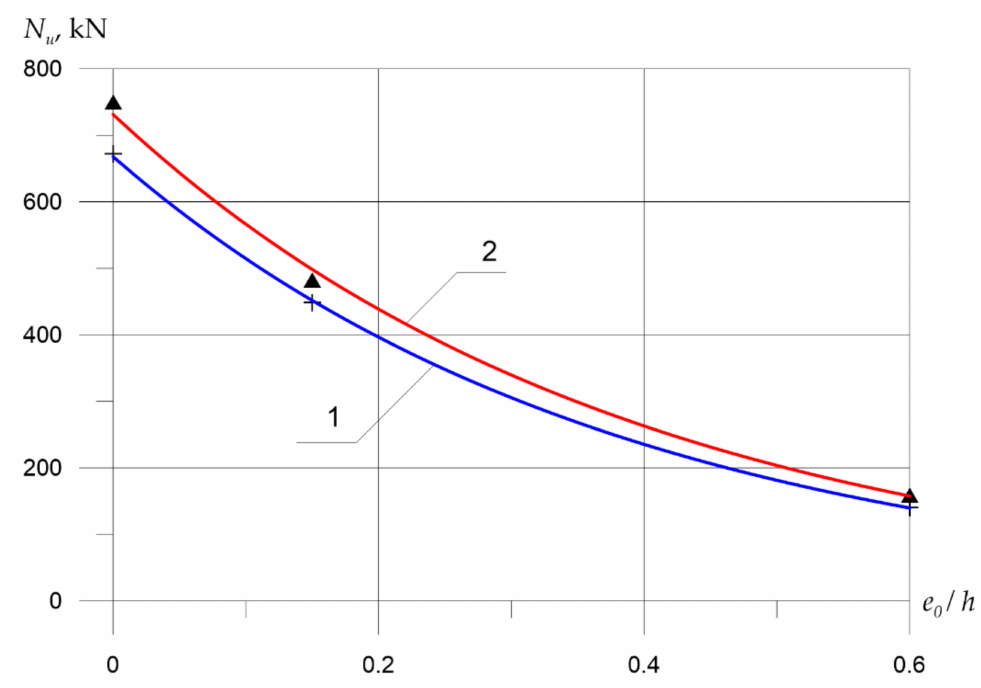
Figure 11. Dependence of the bearing capacity of the racks on the magnitude of the eccentricity; 1—without fiber; 2—with 10% basalt